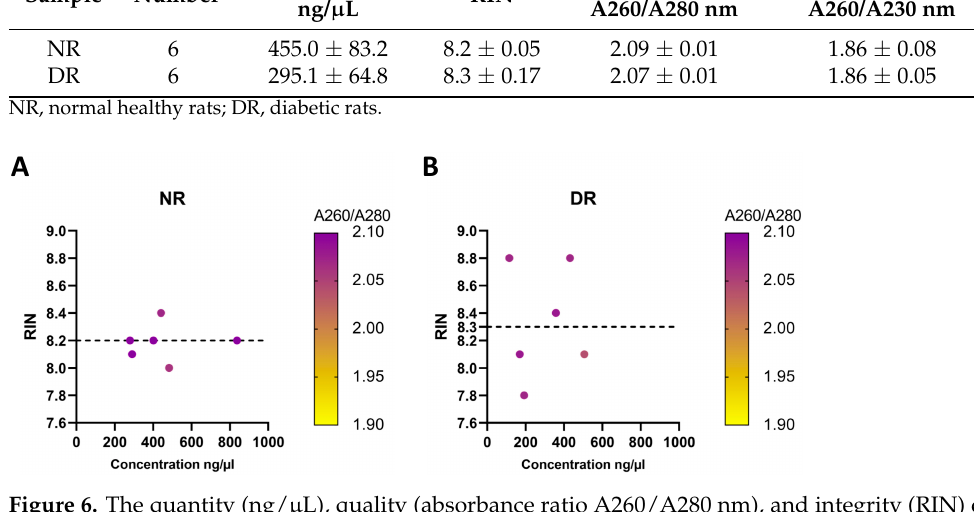
Table 3. Analysis of RNA extracted from healthy or diabetic rats.